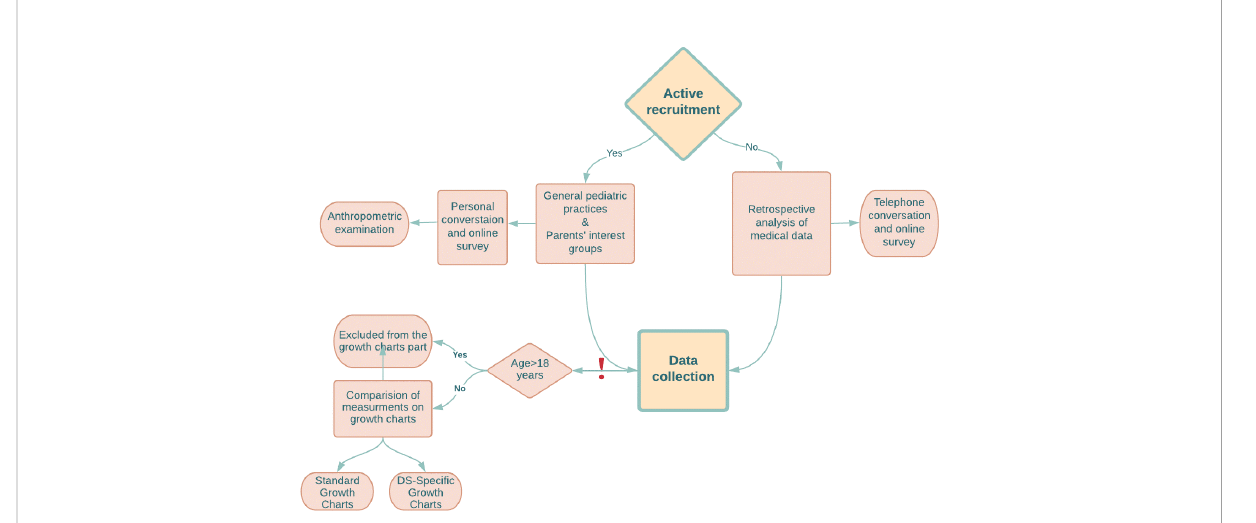
FIGURE 1 The design of the study (Data